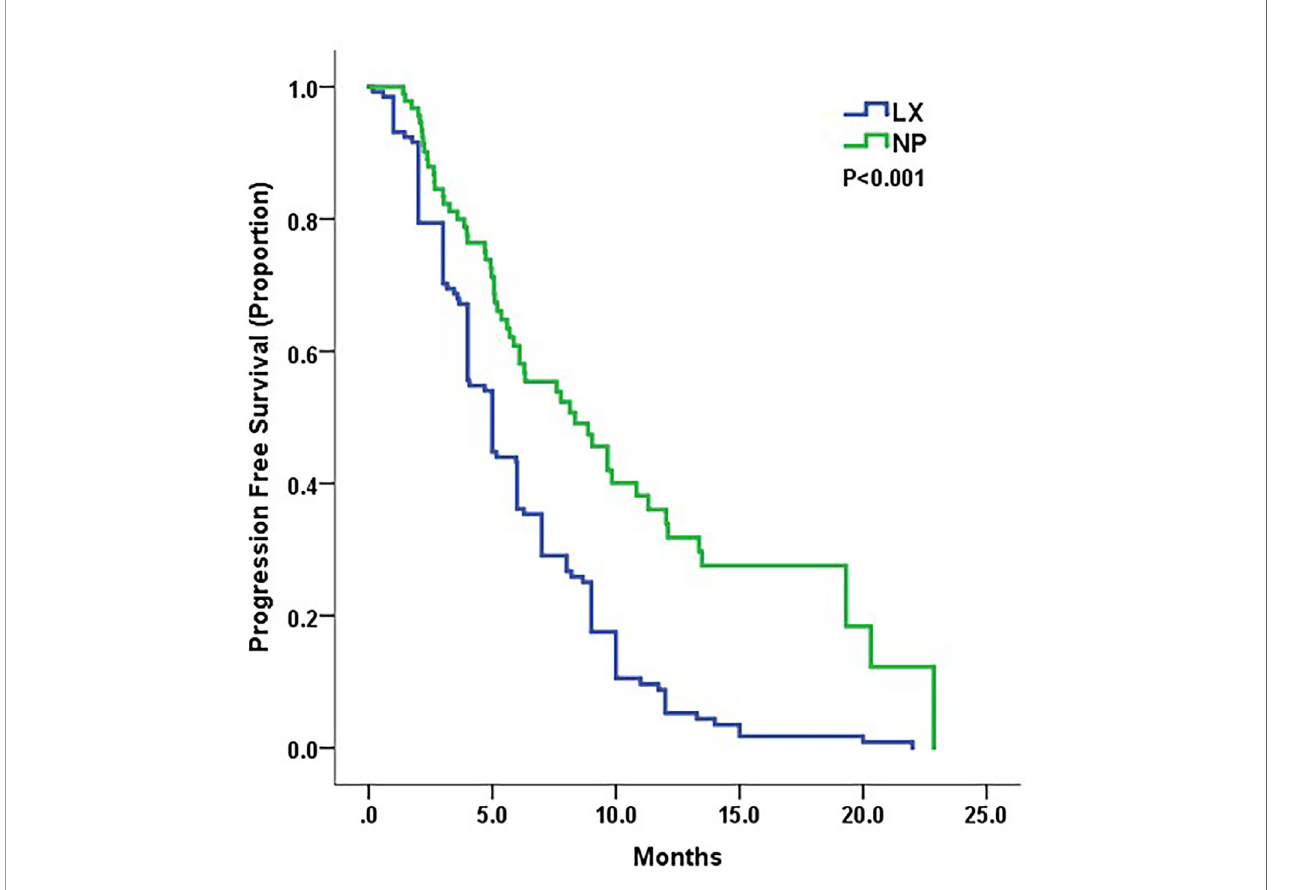
FIGURE 1 | Kaplan – Meier curves for progression-free survival by treatment